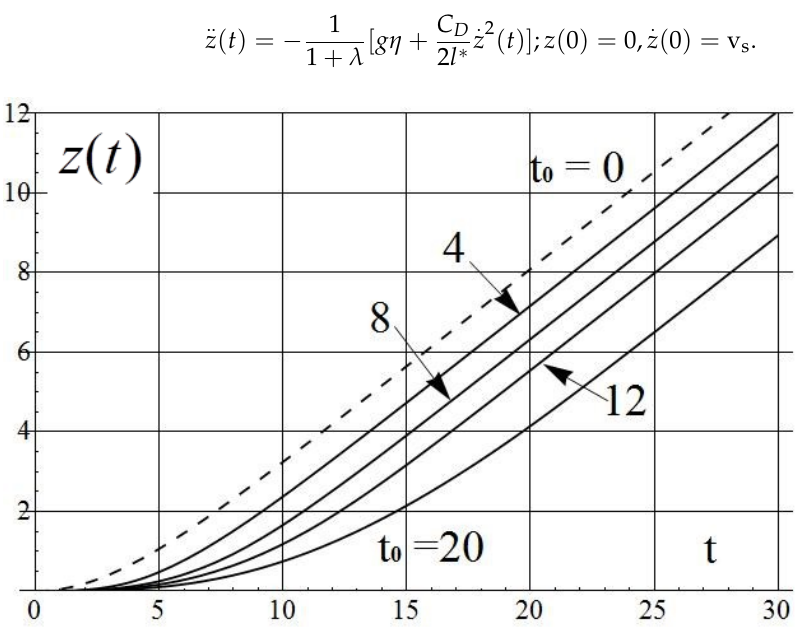
Figure 5. Submersion of the cylinder versus time in accelerated motion for various magnitudes of t 0 , η = 0.01, l c = 1 m.